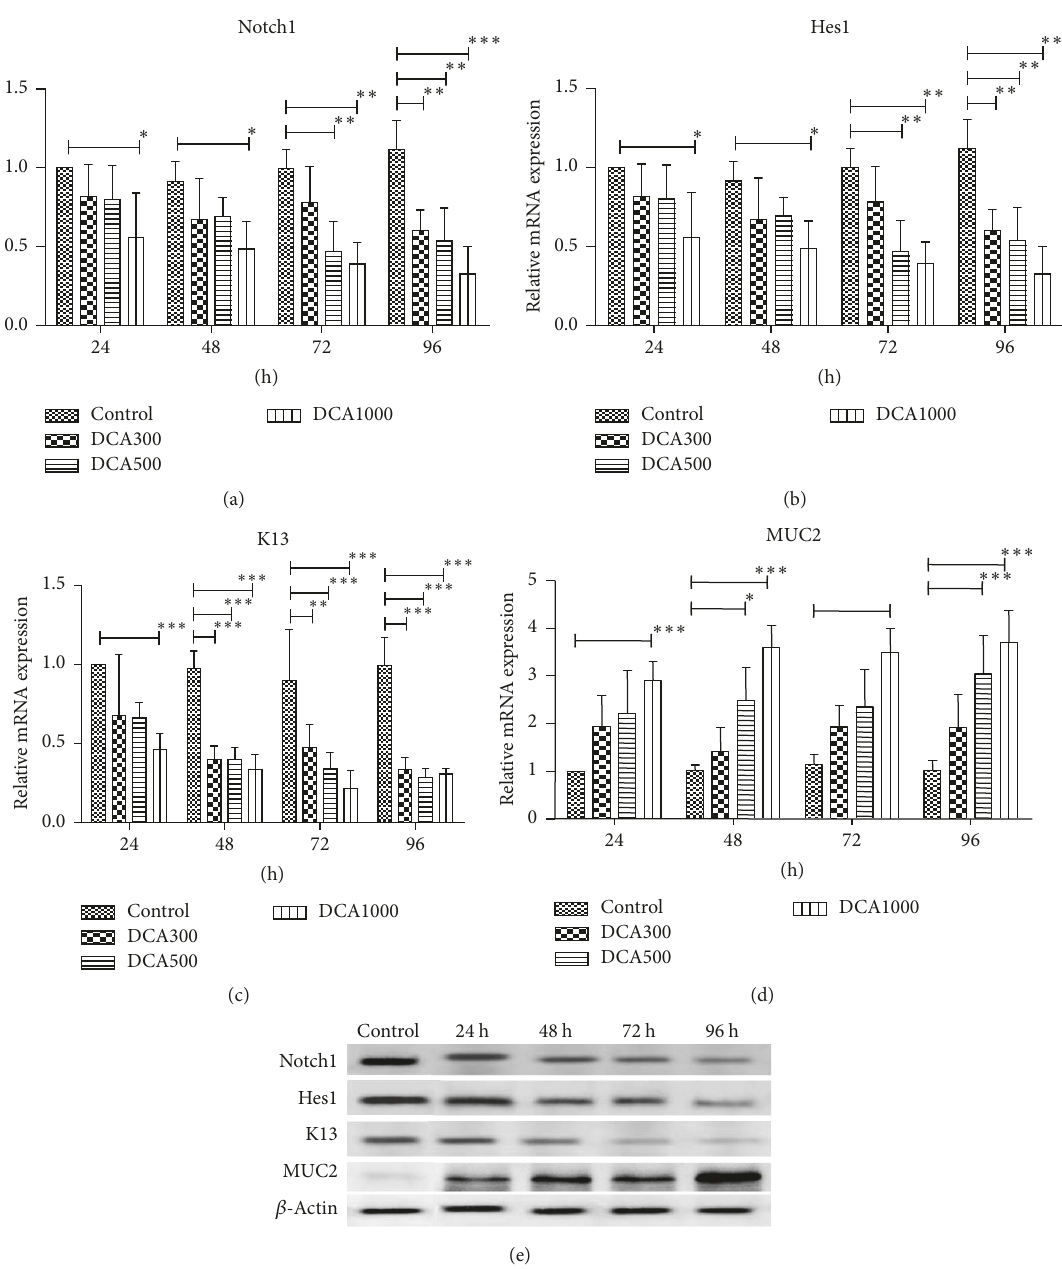
Figure 6: Effects of deoxycholic acid on Notch1, Hes1, K13, and MUC2 expressions. Cells were treated with different concentrations of deoxycholic acid (300 umol/L, 500umol/L and 1000 umol/L) for 24 h, 48 h, 72 h, and 96 h, respectively. (a–d) Notch1, Hes1, K13, and MUC2 mRNA expression levels in Het-1A cells exposing to different concentrations of deoxycholic acid for different time periods. ∗ 𝑝 < 0.05 , statistically significant difference. ∗∗ 𝑝 < 0.01 , statistically significant difference. ∗∗∗ 𝑝 < 0.001 , statistically significant difference. (e) Representative western blot results of Notch1, Hes1, K13, and MUC2 protein expressions in Het-1A cells treated with deoxycholic acid (500 umol/L) for different time